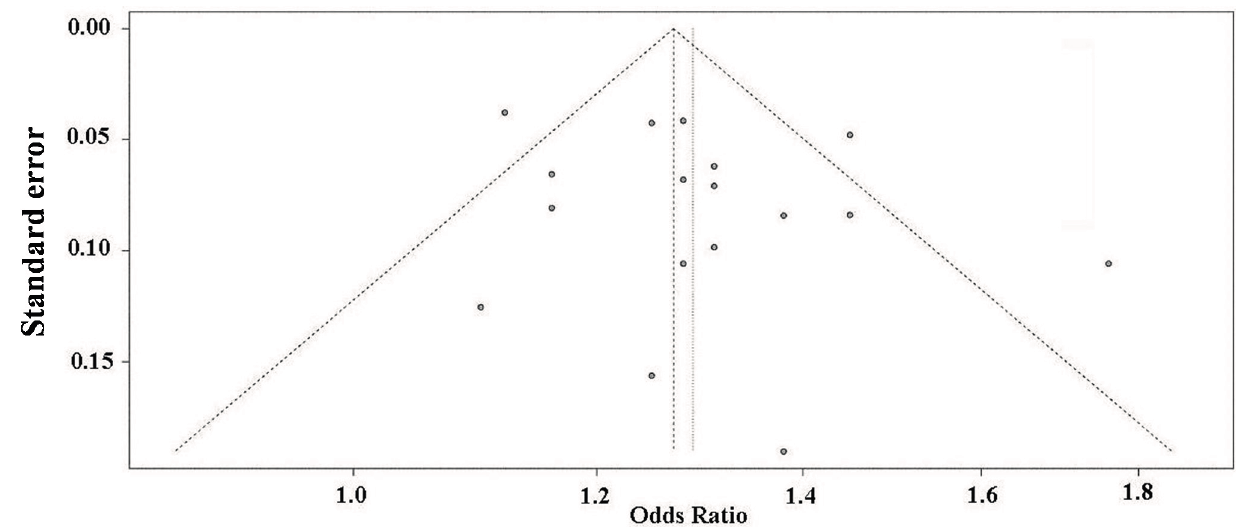
Figure 3. Funnel plot for publication bias analysis of the selected studies investigating the association between rs10757278 polymorphism and MI. The X -axis stands for the ORs and the Y -axis is the standard error for each of the selected studies. A linear regression based approach proposed by Egger et al. [19] is used to evaluate the asymmetry of the funnel